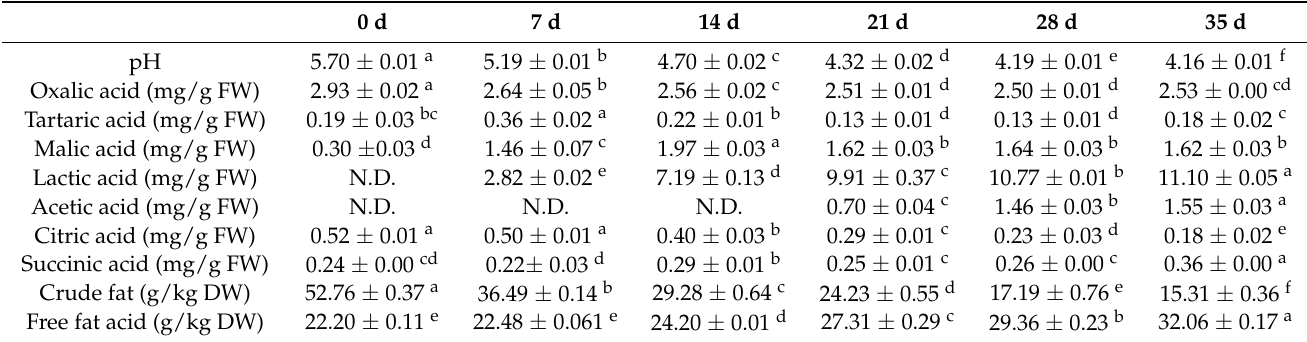
Table 2. Changes in the related physiochemical properties during